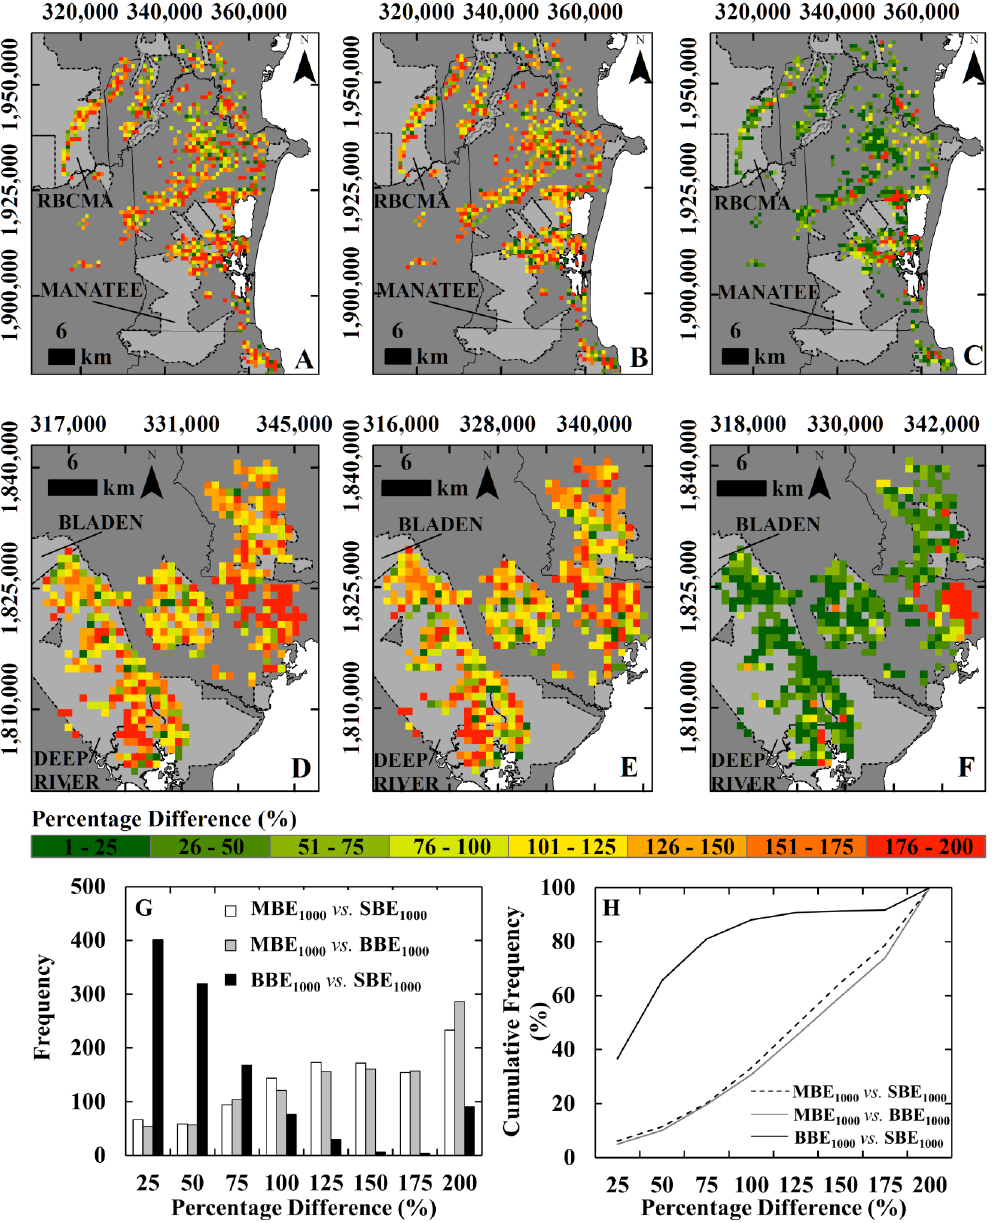
Figure 9. Percentage differences as calculated from Equation (7) per 1000-m pixel for the comparisons between ( A , D ) MBE 1000 vs . BBE 1000 , ( B , E ) MBE 1000 vs . SBE 1000 and ( C , F ) BBE 1000 vs . SBE 1000 for northern and southern Belizean savannas within the ALOS PALSAR scenes; in histogram ( G ), we show the distribution of the percentage differences pixel-wise for each biomass map comparison group, and in scatterplot ( H ), we show the relationship between the percentage difference for each pixel and the biomass estimated for the same pixel using the MBE 1000